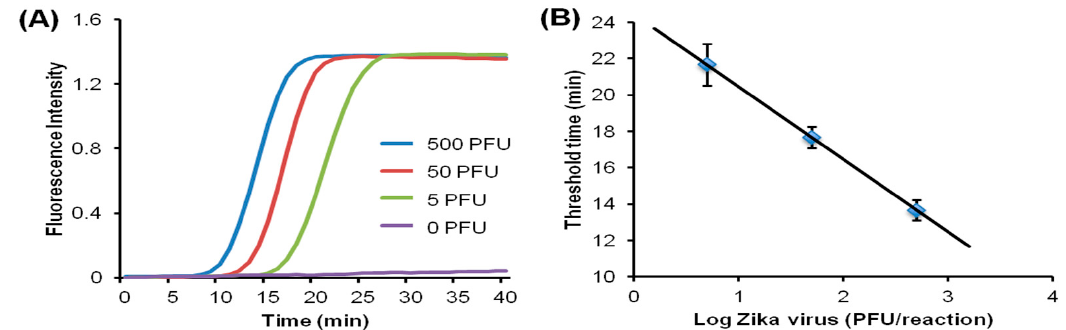
Figure 6. Chip-based LAMP POC diagnostics. Detection with fluorescent intercalating dye: excitation with Smartphone flashlight LED, emission intensity monitored with a Smartphone CCD